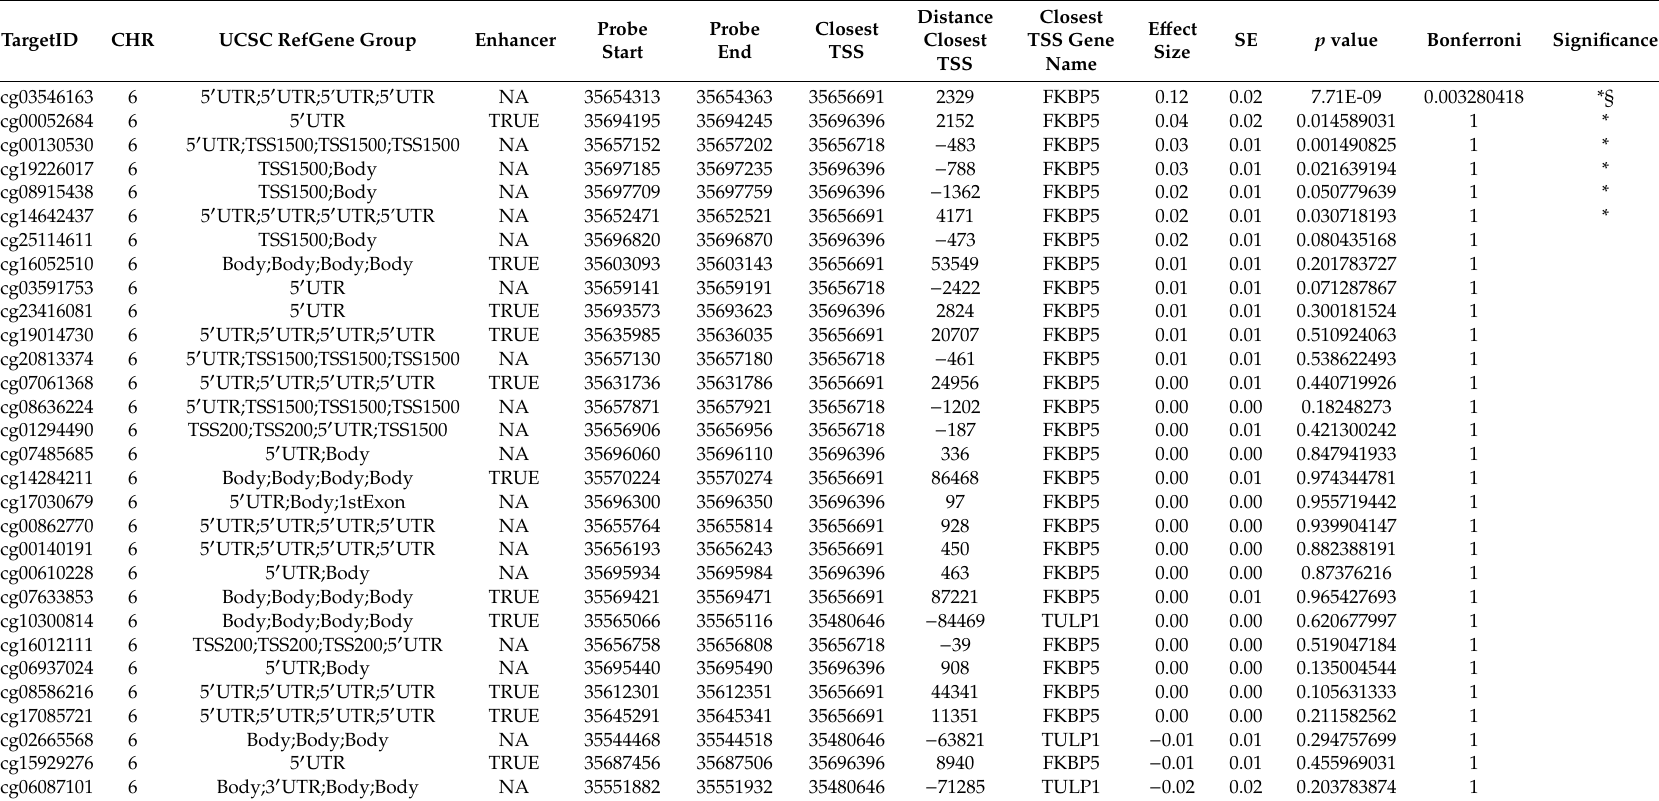
Table 1. Di ff erential DNAm analyses of the FKBP5 gene ordered by e ff ect size (low survival group was used as reference). Information about single CpGs including location-related values and model outputs (e ff ect size, standard error, p